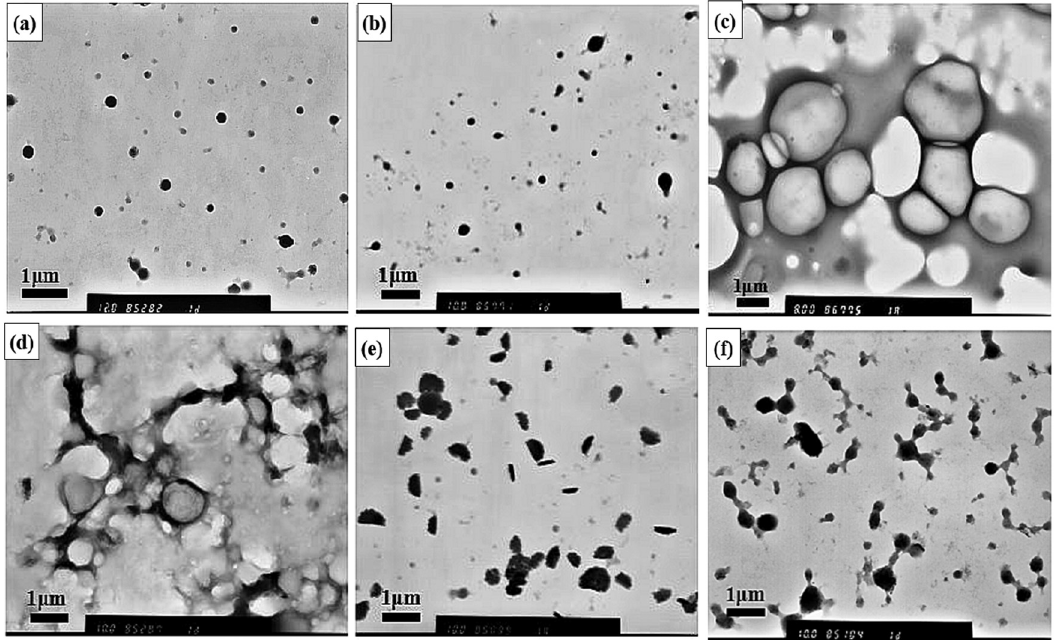
Figure 7: TEM images of aggregates formed from DSPE – PEG1k/MPEG – PDLLA mixtures with the mass ratio of DSPE – PEG1k to MPEG – PDLLA: ( a ) 0:1, ( b ) 0.001:1, ( c ) 0.005:1, ( d ) 0.01:1, ( e ) 0.02:1 and ( f )